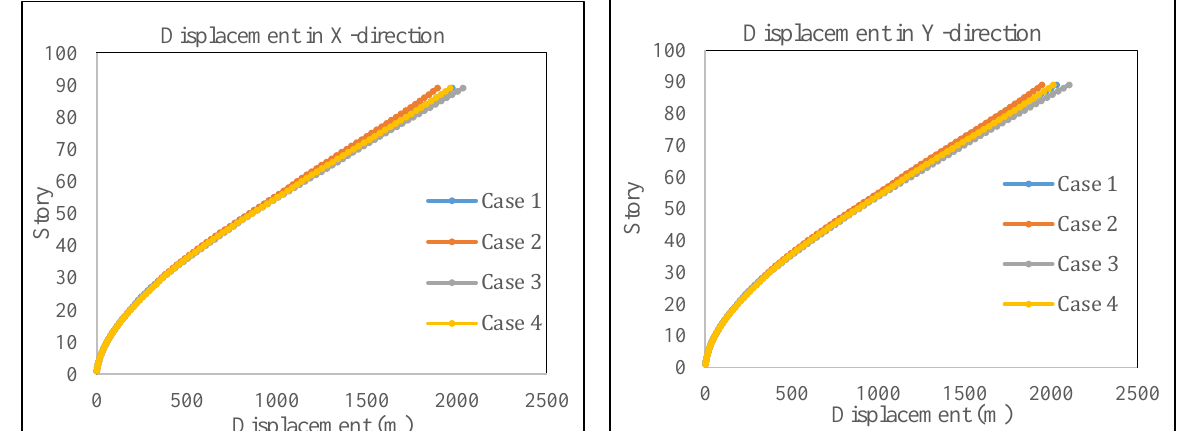
Fig. 6. Story-Displacement curves in X and Y directions for R=1.